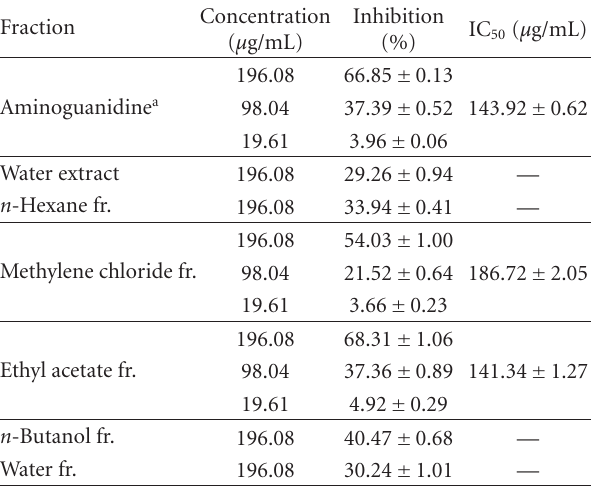
Table 4: Inhibitory e ff ects of the P. vulgaris L. on advanced gly- cation end products (AGEs).